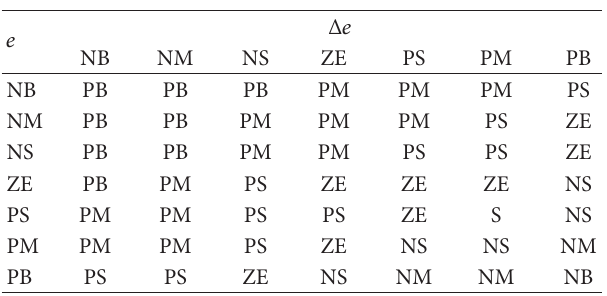
Figure 6: Block diagram of phase-locked loop.